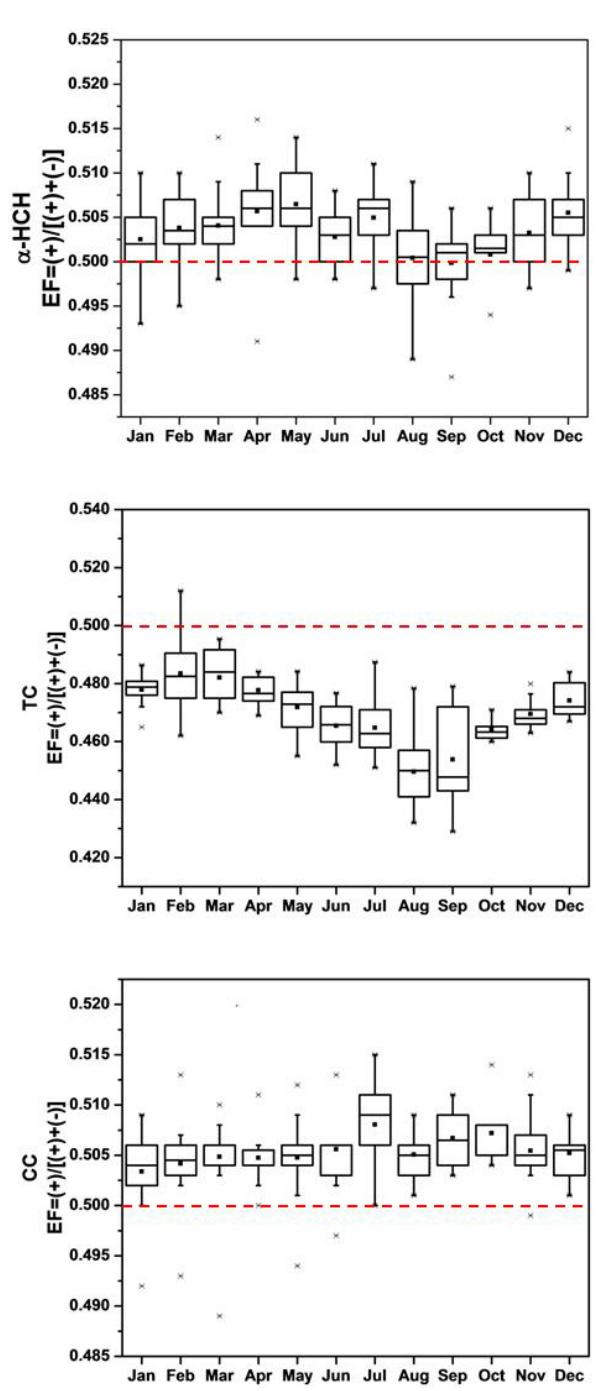
Figure 1. Box and whisker plots of monthly EFs over all 7 years: arithmetic mean (square), median (horizontal line), 10th– 90th percentiles (whiskers), 25th–75th percentiles (boxes) and out- liers (crosses). The dashed red line indicates a racemic composition.